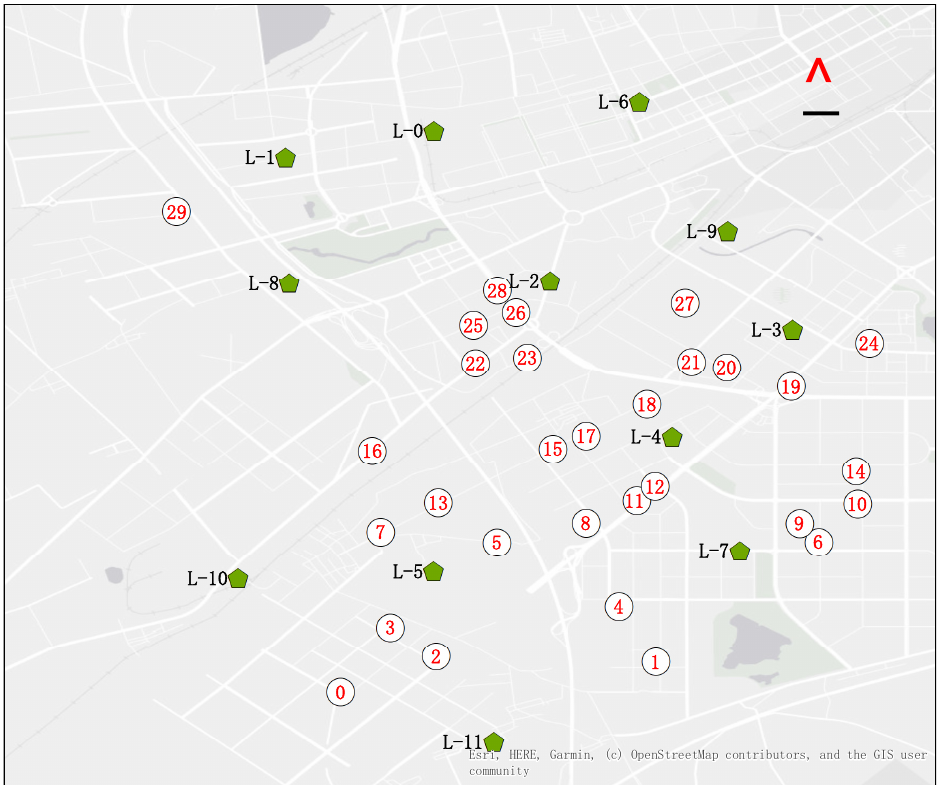
Figure 3. Description of the study area.